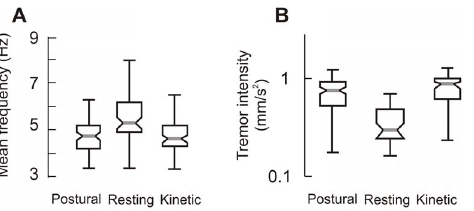
Figure 3. Summary of the frequency and intensity of the postural, resting and kinetic tremor from 79 A–T subjects. Frequency (A) and intensity (B) is plotted on the y-axis. Each box- whisker plot depicts one condition. Grey horizontal line depicts median value, notches correspond to 95% confidence interval, length of box depict quartile values, and whiskers depict range. Panel ‘A’ compares the frequency, while panel ‘B’ compares the intensity.